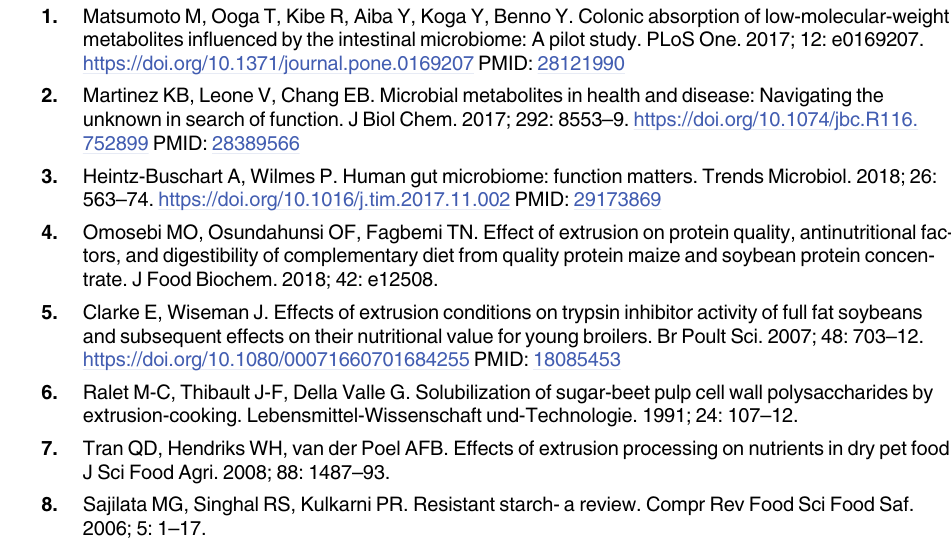
S4 Table. Loadings for sparse partial least squares analysis for the metabolome and micro- biome at weeks 3 and 6. S5 Table. Alpha and beta diversity plots versus order